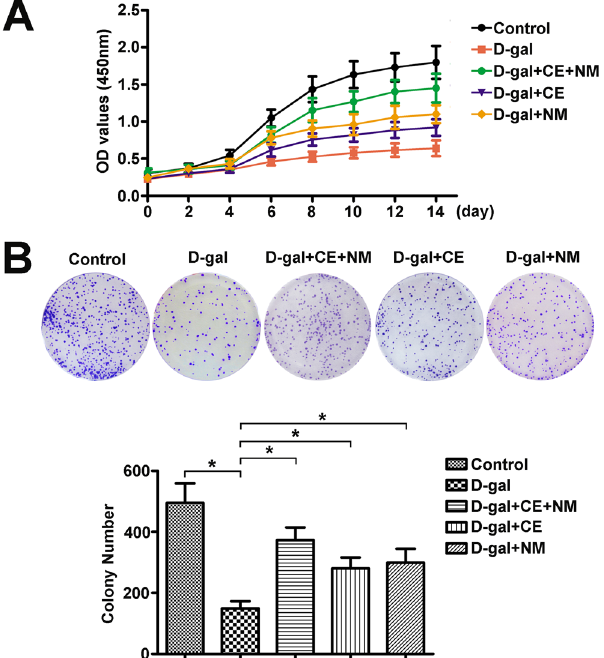
Figure 2. CE and NM supplement effect on proliferation of BMSCs in aging rats. ( A ) BMSCs from different groups were plated in triplicate in 96-well plates at a density of 1 × 10 3 cells per well, and cell proliferation was examined using CCK-8 kit for 14 consecutive days and growth curve was calculated. ( B ) The colony form of BMSCs was performed in control rats, D-gal rats, CE and NM treated aging rats. Morphology foci were observed at the microscope and photographed. Significant regulation of colony formation numbers was confirmed in BMSCs from D-gal rats compared with control, and CE and NM treated rats compared with D-gal rats. Data were the means ± SD of triplicate determinants ( * P <